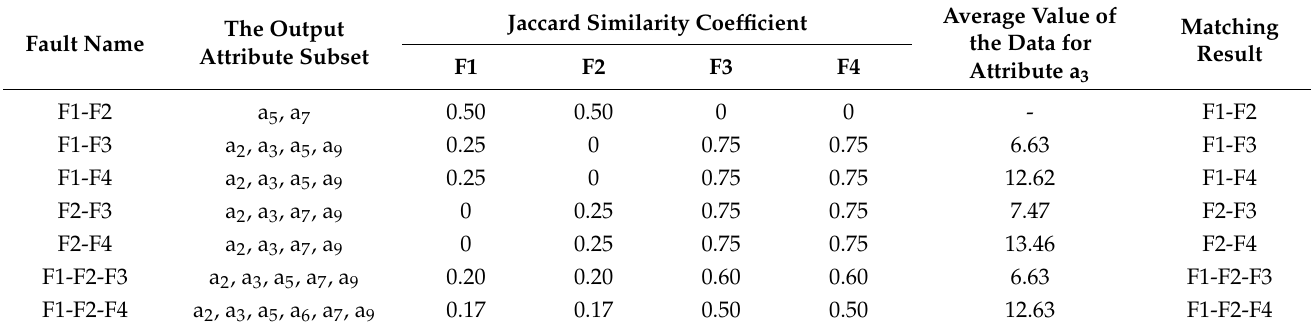
Table 10. The results of the testing